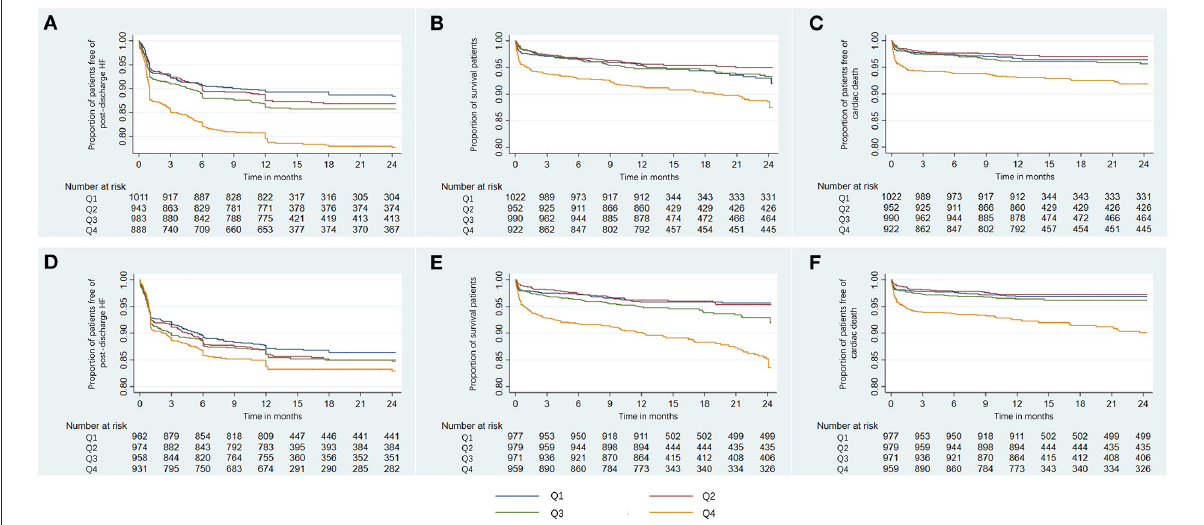
FIGURE2 Kaplan-Meier curves of the proportion of AMI patients free of clinical outcomes. Shown are the proportion of patients free of post-discharge HF (A) , survival rate (B) , and the proportion of patients free of cardiac death (C) for serum phosphorus, and the proportion of patients free of post-discharge HF (D) , survival rate (E) , and the proportion of patients free of cardiac death (F) for corrected serum calcium. AMI, acute myocardial infarction; HF, heart failure; Q,